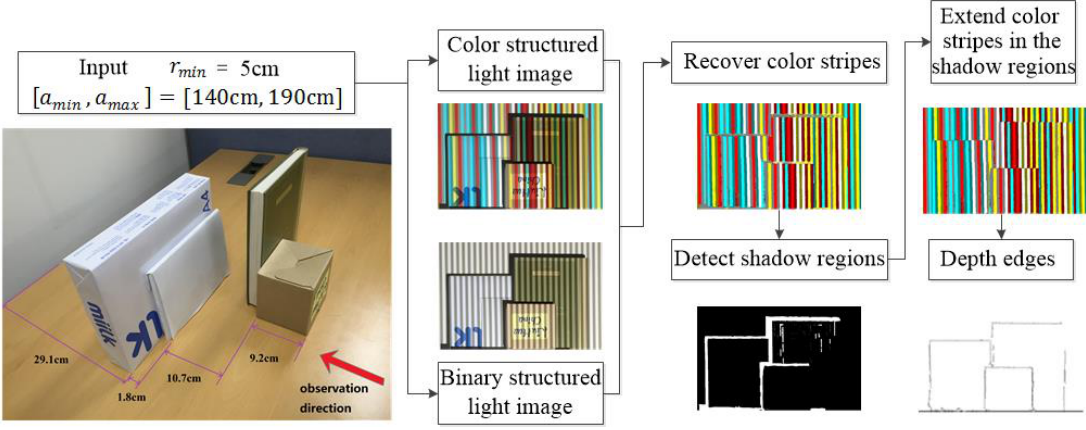
Figure 2. An overview of our method.